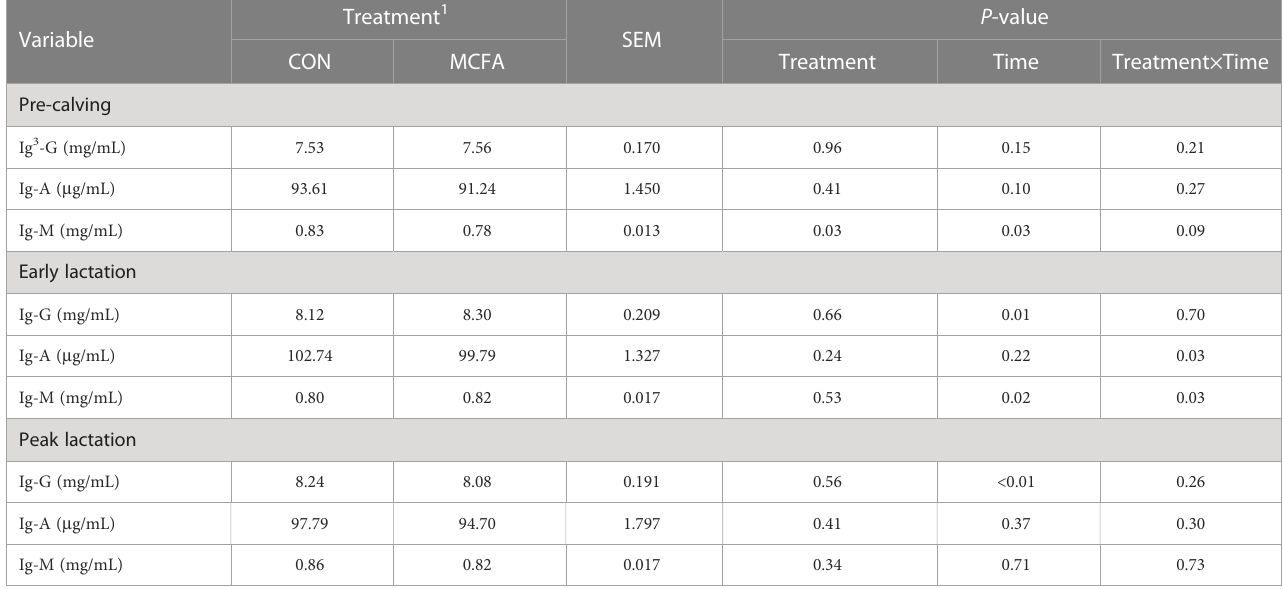
TABLE 6 Effects of feeding medium chain fatty acid on blood immune globulin of the pre-calving, early lactation, and peak lactation cows 2 . P -value Treatment 1 Variable SEM CON MCFA Treatment Time Treatment×Time Pre-calving